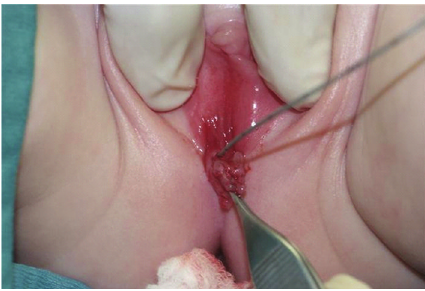
Figure 3: Intraoperative picture showing a 2F ureteral catheter exiting a tiny urethral meatus. A Hegar dilator is inserted in the vagina.